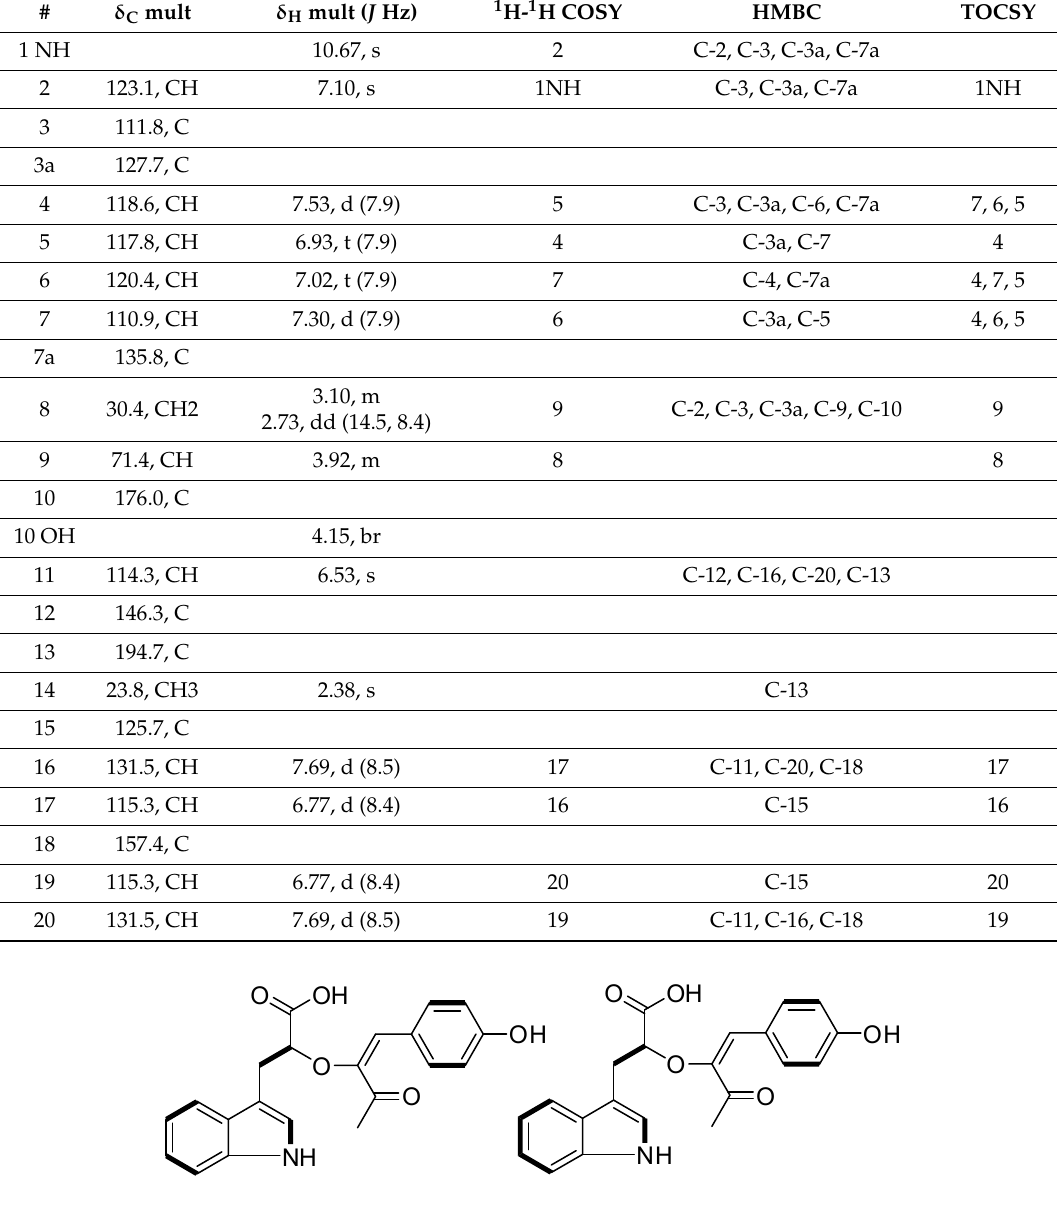
Table 1. 1D and 2D-NMR spectroscopic data for compound ( 1 ) in DMSO- d 6 , in ppm.